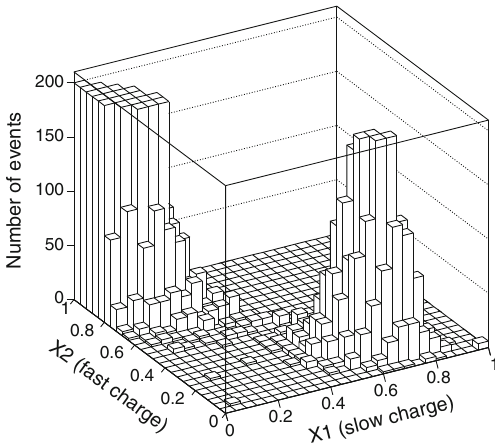
Fig. 18 A two-dimensional plot of the fast and slow charge fractions forCrystal-1.PMTnoiseeventspopulatethehighX2andlowX1region while signal events have low values of X2 and high values of X1